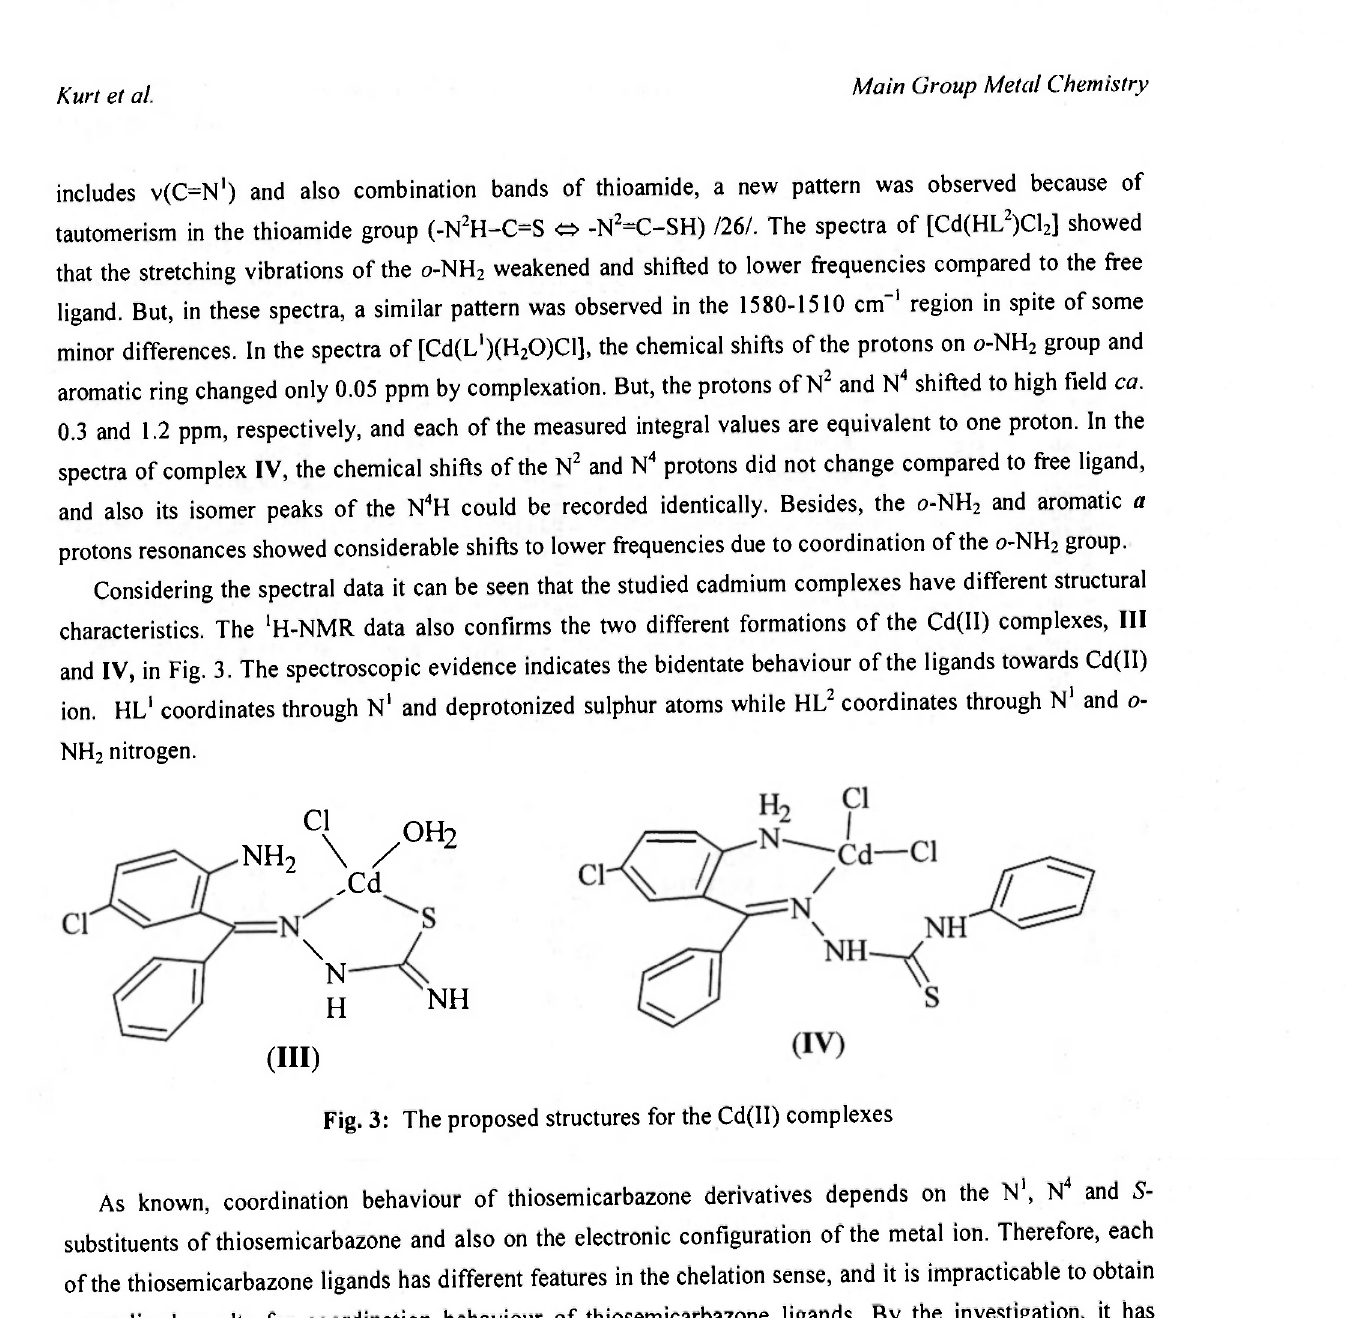
Fig. 3: The proposed structures for the Cd(II)